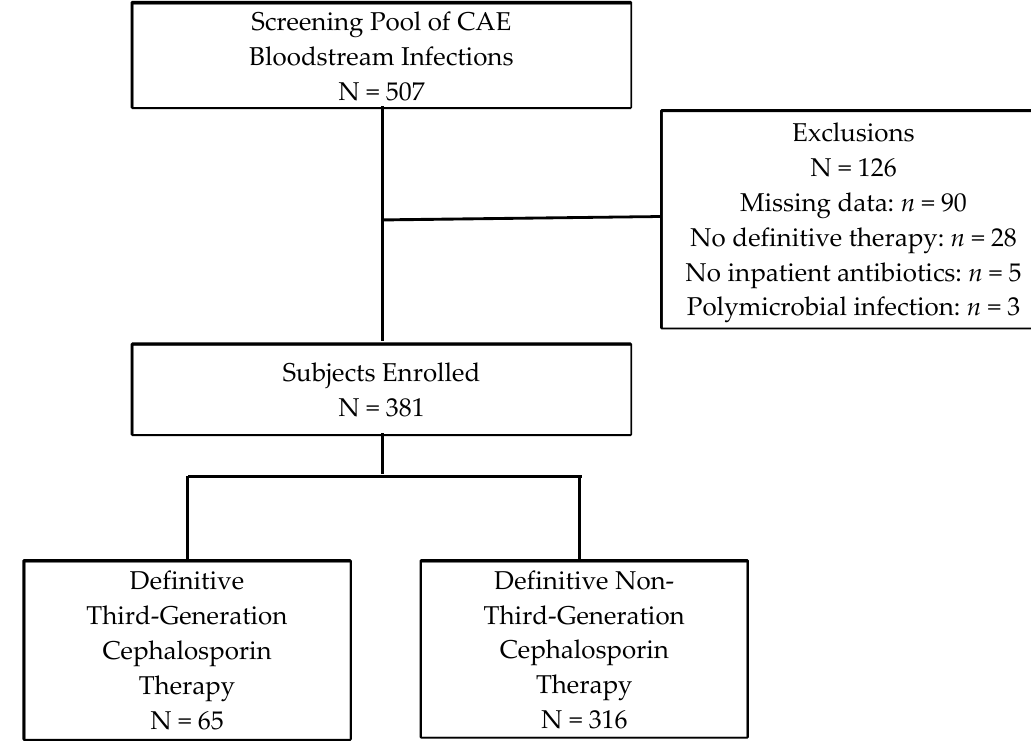
Figure 1. Flow diagram of subject enrollment. Table 1. Baseline characteristics of patients on definitive therapy with third-generation cephalosporin (3GC) versus other antimicrobial agents.